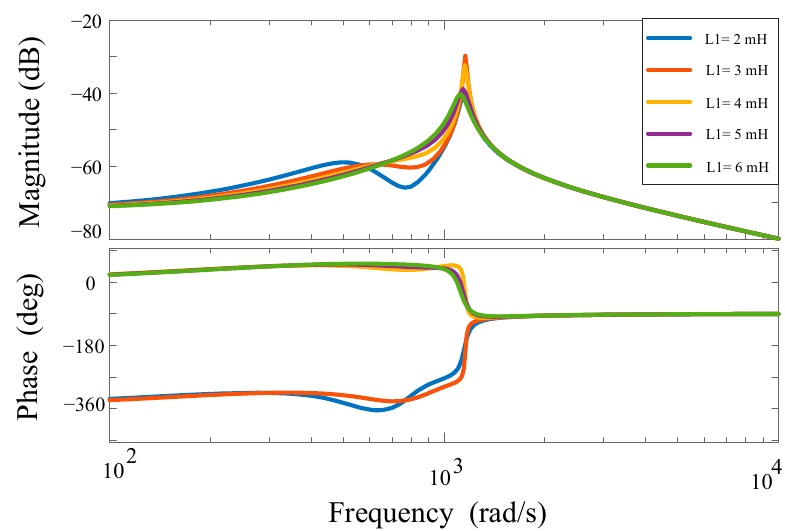
Figure 8. Bode diagram of the transfer function of the disturbance.